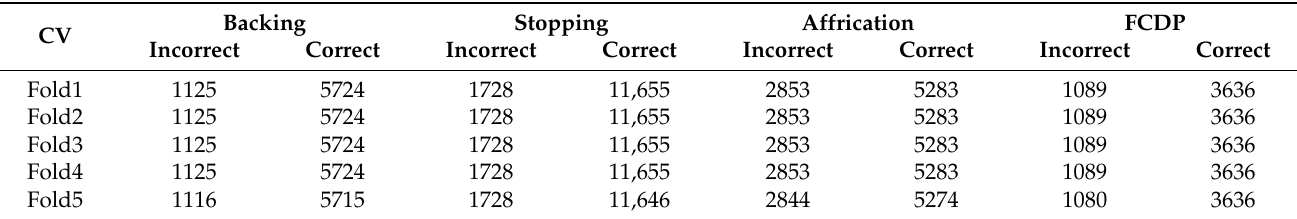
Table 4. The amount of data on the single-Chinese-character dataset for training.